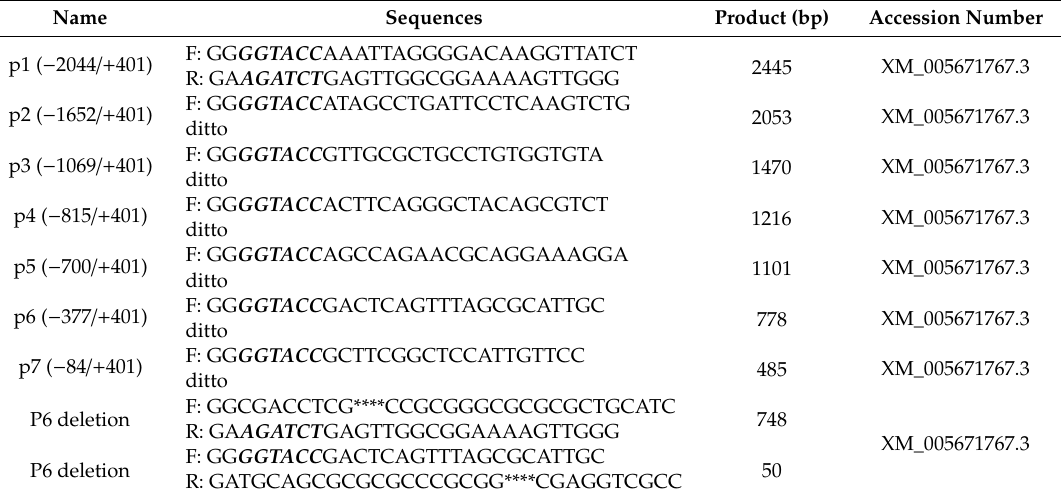
Table 2. Primers for 5 (cid:48) deletion fragments of FGFR1